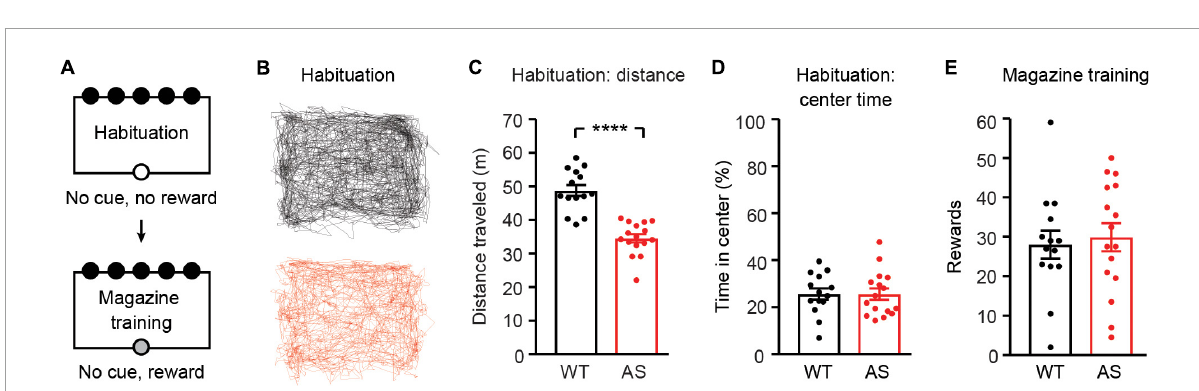
FIGURE2 Ube3a m − / p + mice are hypoactive during habituation and receive normal rewards during magazine training. WT: black, n = 14. Ube3a m − / p + (AS): red, n = 16. (A) Schematic of habituation and magazine training phases. (B) Example paths of individual WT and Ube3a m − / p + mice during habituation. (C) Distance traveled and (D) time spent in the center of the arena during habituation. (E) Average rewards received across 2 days of magazine training. **** p < 0.0001. Error bars indicate ± SEM.